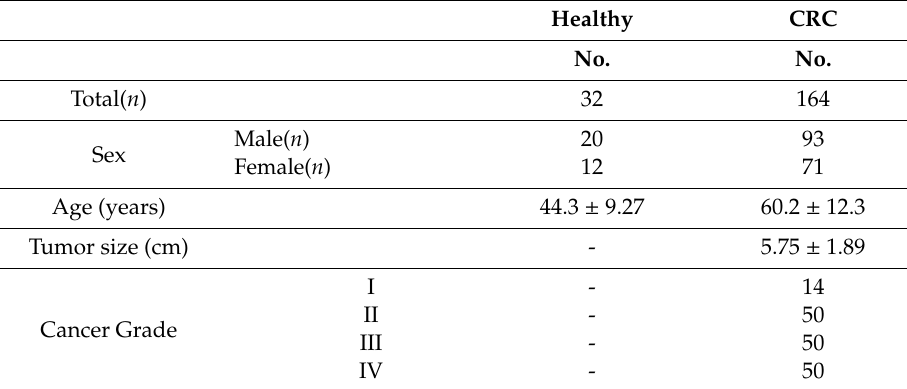
Table 1. Clinical features of healthy controls and